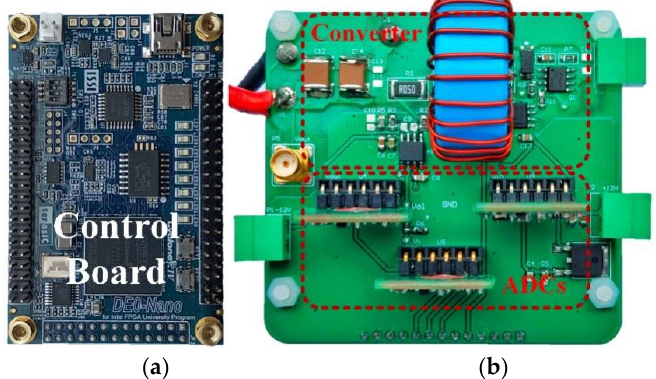
Figure 18. The experimental prototype: ( a ) Control board and ( b ) buck converter.